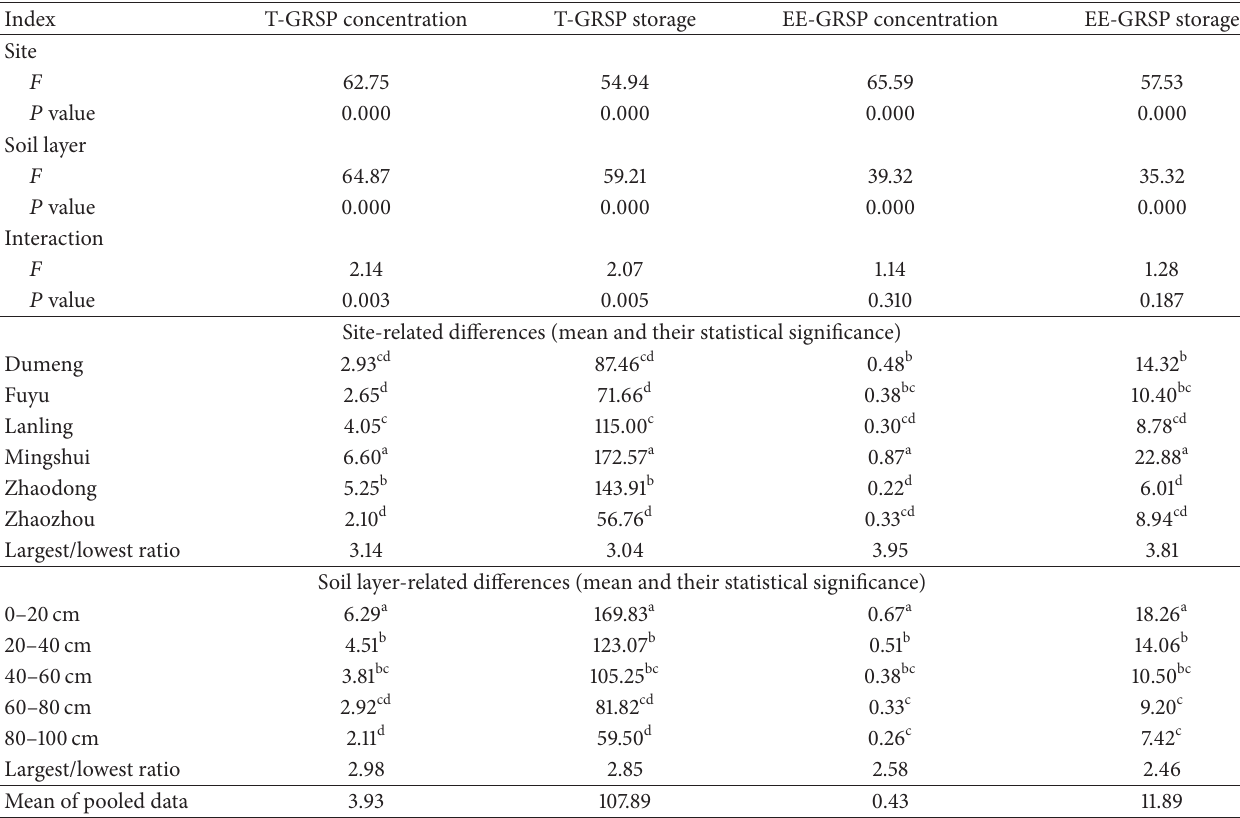
Table 3: Two-way ANOVA results on spatial (site, soil layer) varaitions of GRSP (T-GRSP, EE-GRSP) concentration in poplar shelterbelt forests in Songnen Plain.